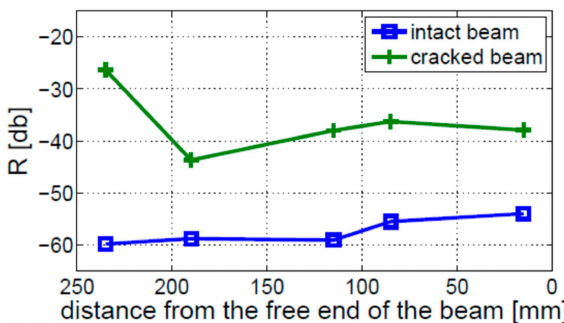
Figure 20. Values of modulation intensity coefficient R measured along the intact and cracked beams (Experimental Test 1) for free–free boundary conditions: ( a ) intact beam; ( b ) cracked